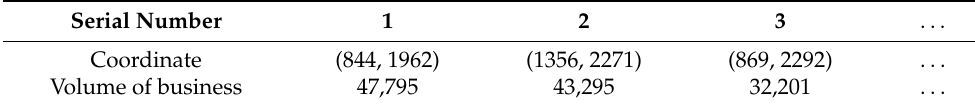
Table 2. Some of the isolated points with high data